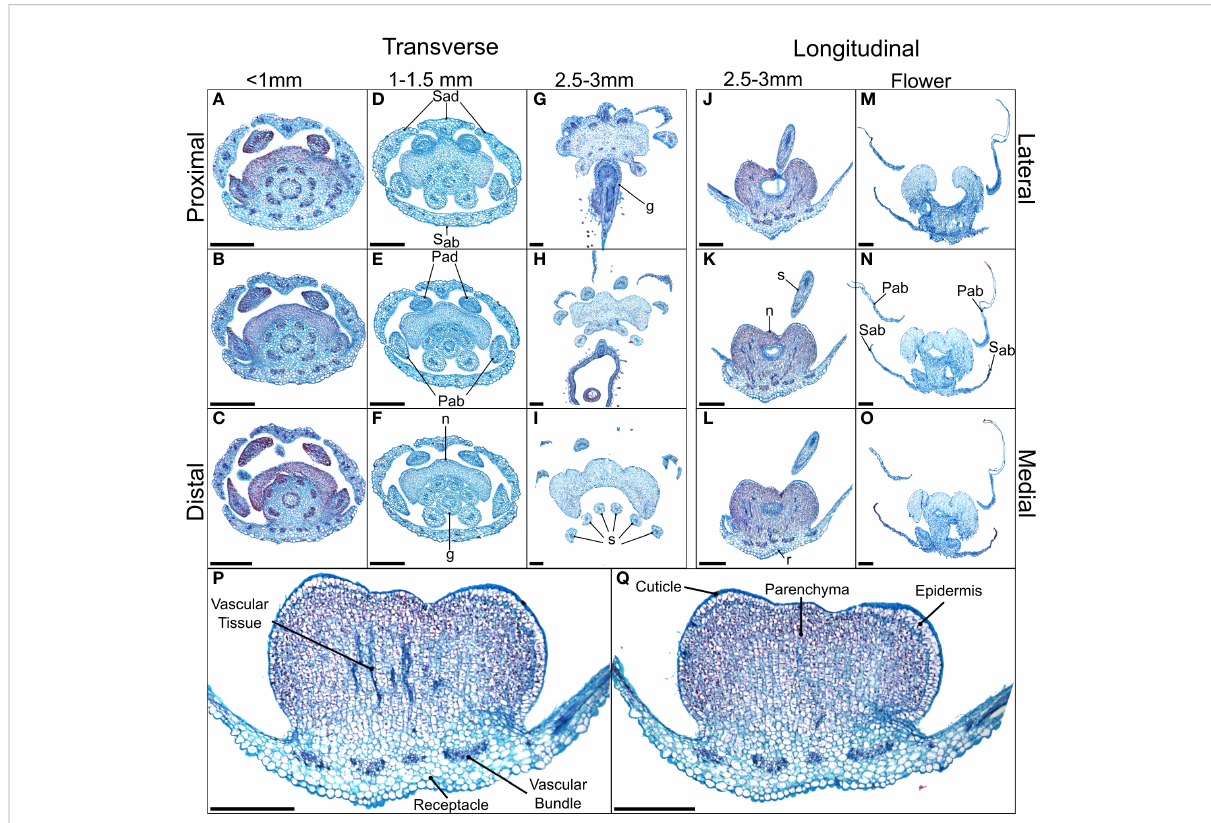
FIGURE 2 Alcian blue/safranin O-stained sections of Cleome violacea nectaries at pre-anthetic, anthetic and post-anthetic stages. From left to right: (A – C) small, (D – F) medium, and (G – I) large buds in transverse view with proximal-distal indicating relative distance to receptacle. (J – L) Large bud and (M – O) fl owers in longitudinal view with lateral-medial indicating relative distance from center. (P, Q) Longitudinal view of 20 m m slices of the same large fl oral bud with and without vascular tissue, respectively. Scale bars = 250 m m. Sad = adaxial sepal; Sab = abaxial sepal; Pad = adaxial petal; Pab = abaxial petal; s = stamen; g = gynoecium, r =